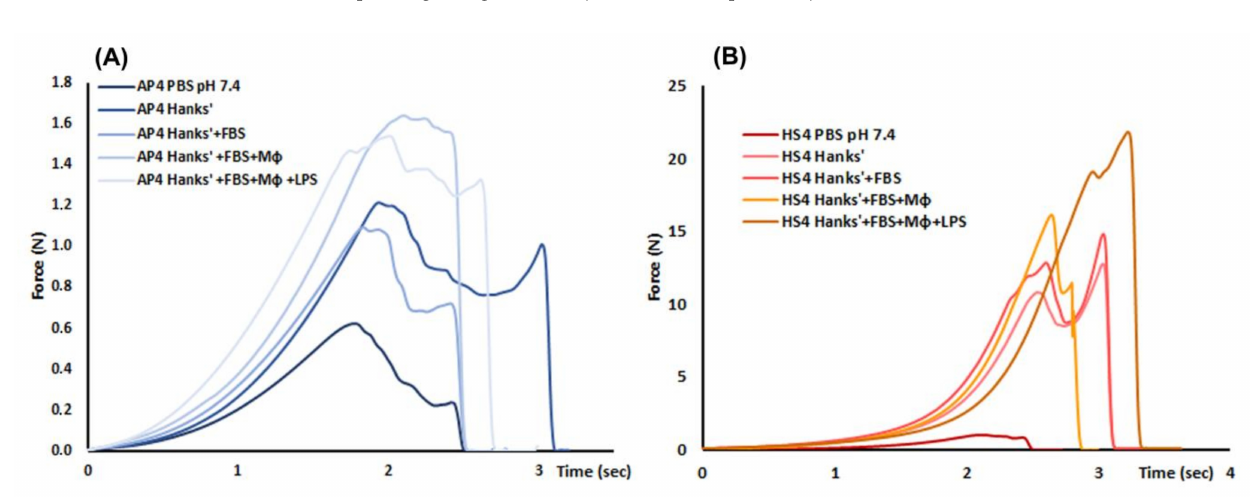
Abbreviations are given as in Figure 6. The data are presented as the mean ± S.D. (n = 15). a p < 0.05 vs. the